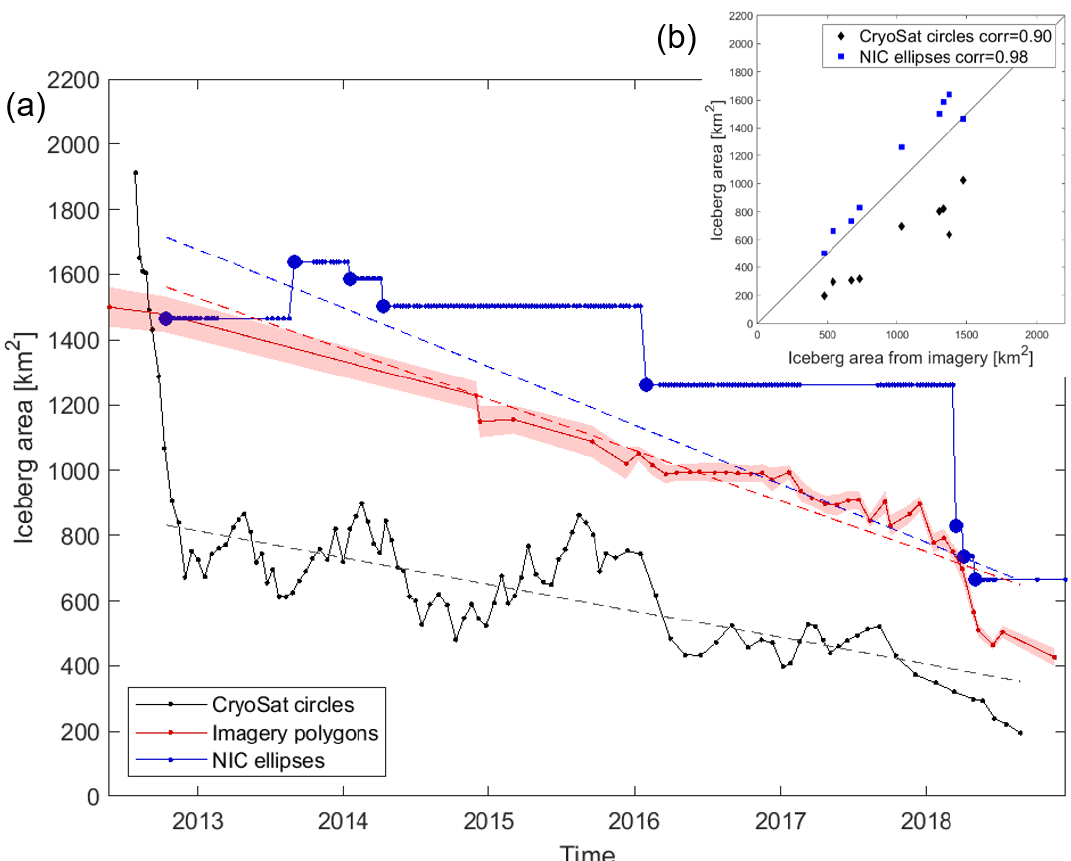
Figure 6. Area change in the B30 iceberg from polygons delineated in satellite imagery with their uncertainty (red) and approximations using orthogonal axes provided by the National Ice Center (NIC) assuming an elliptical shape (blue) or using the arc lengths of CryoSat-2 overflights assuming a circular shape (black) over time (a) and as scatter plot (b) . To fit the NIC trend line in (a) we only use unique values of orthogonal axis length (thick blue dots). These also define the dates of comparison in (b)